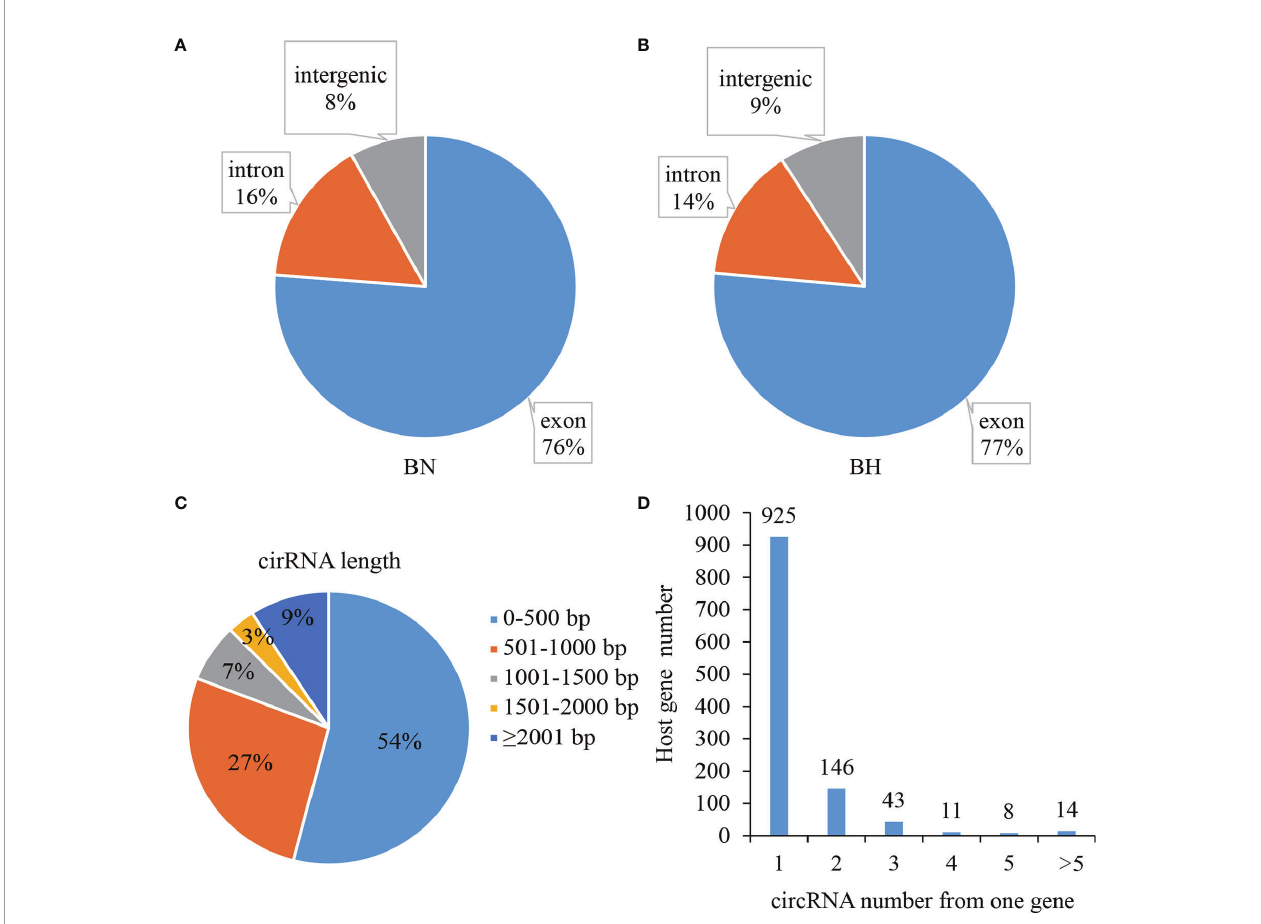
FIGURE 1 | Summary statistics of circular RNA (circRNA) in blind-side skin tissues of tongue sole. (A) Derivation distribution of circRNAs in blind-side normal (BN) and blind-side hypermelanotic (BH) groups. (B) Length distribution of circRNAs. (C) CircRNA numbers from host gene. (D) CircRNA numbers from host